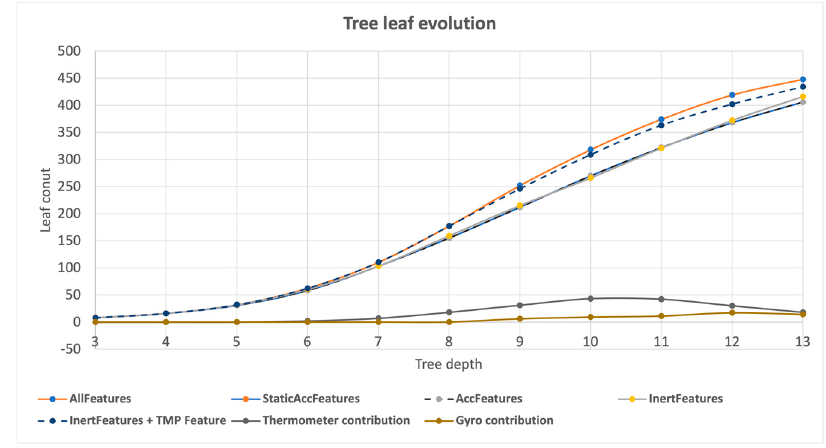
Figure 5. Tree leaf count evolution with tree depth. Table 6. Balanced accuracies by sensor.